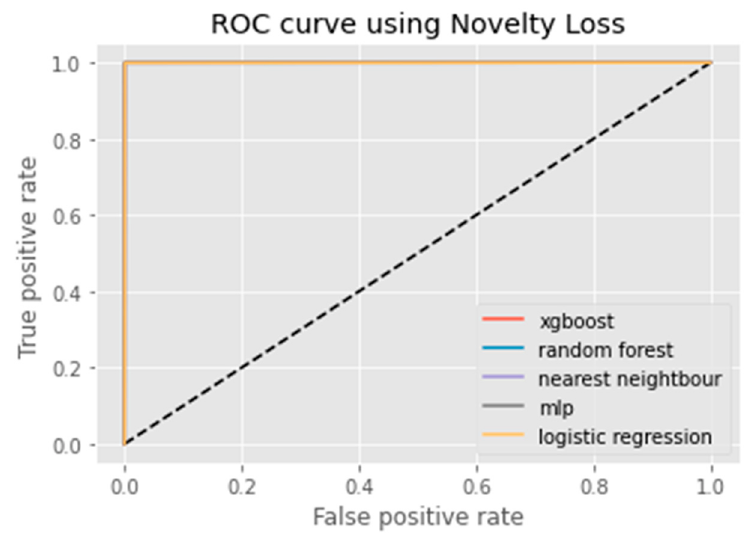
Figure 11. ROC curve using LS GAN.